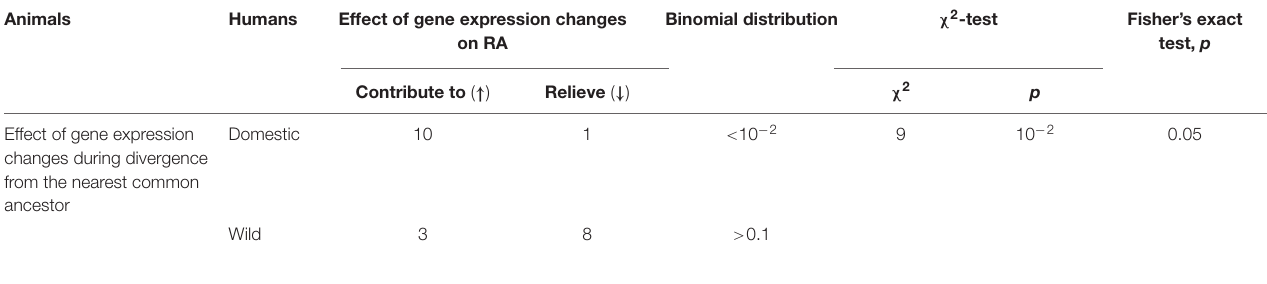
TABLE 4 | Correlations between the effects of codirected changes in the expression of orthologous genes on rheumatoid arthritis (RA) in humans and during the divergence of domestic and wild animals from their nearest common ancestor. Animals Humans Effect of gene expression changes on